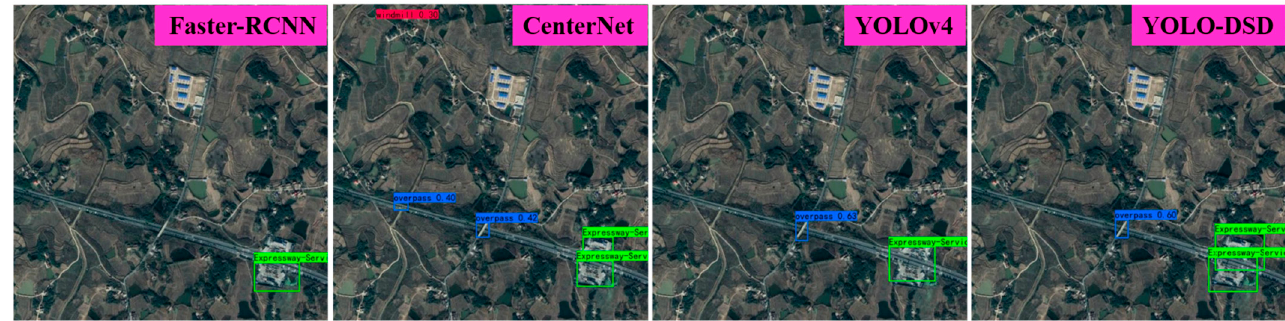
Figure 17. The detection result of instance in complex urban background.